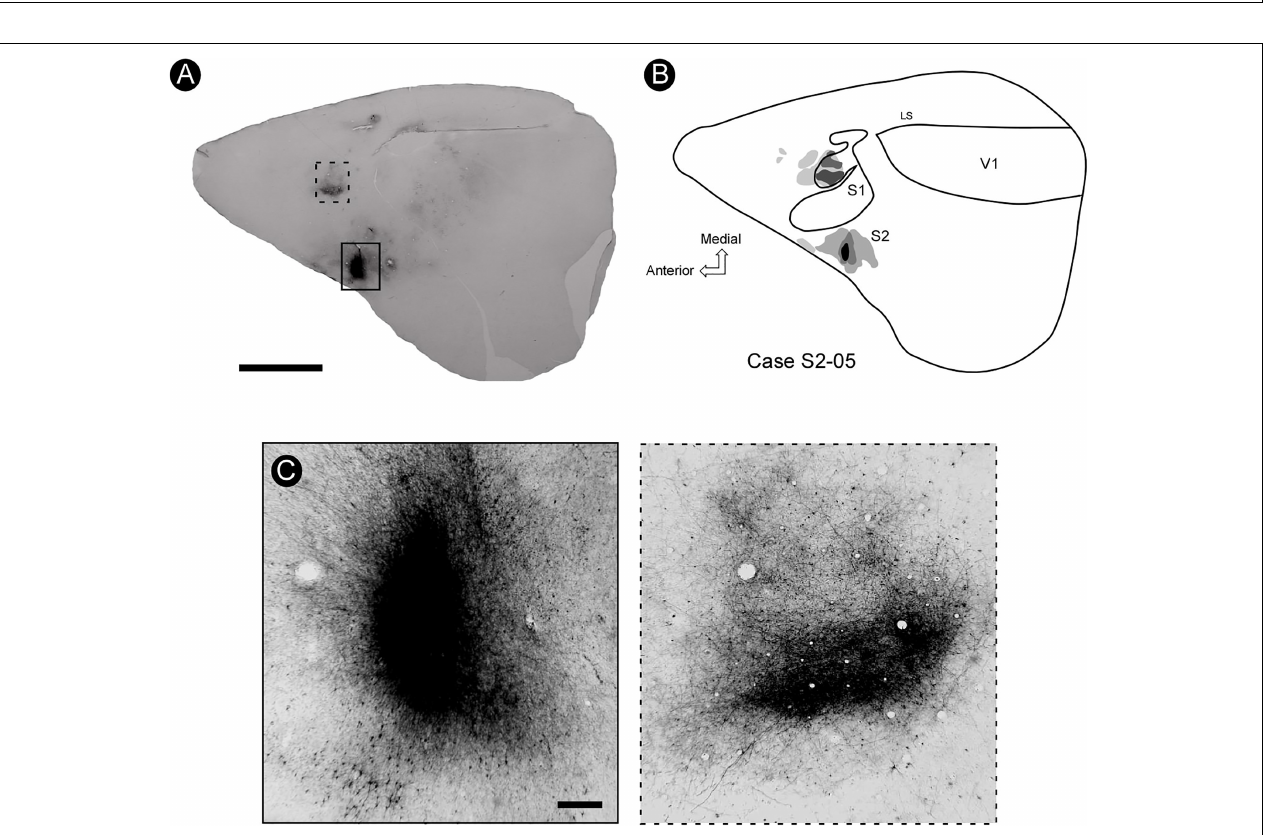
FIGURE 7 | The pattern of connectivity between S2 and S1. (A) BDA injection (marked with a solid rectangle) in the representation of the forelimb in S2 is connected with its counterpart region in S1, as revealed by a dense focus of projection (dashed rectangle). (B) General reconstruction of a tangential section showing the site of injection of BDA in S2 and its projection to S1. It is possible to identify two foci located rostrally to this region, as well as a small focus near the rhinal fissure, probably area PR. (C) Enlargement of the site of injection in S2 (left) and the focus of projection in S1 (right). Scale bars: A : 5 mm; B,C : 500 µ m. LS, lateral